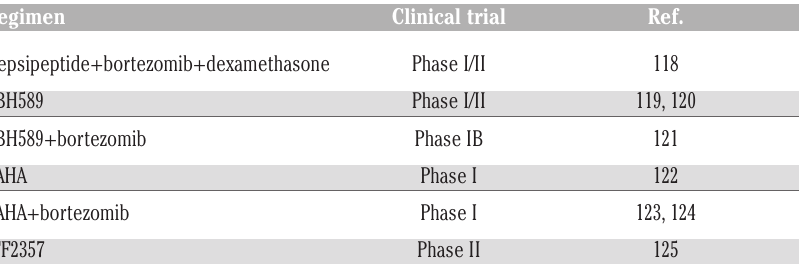
Table 3. Ongoing clinical trials with HDACi as single agent or in combination therapy in MM patients. Regimen Clinical trial